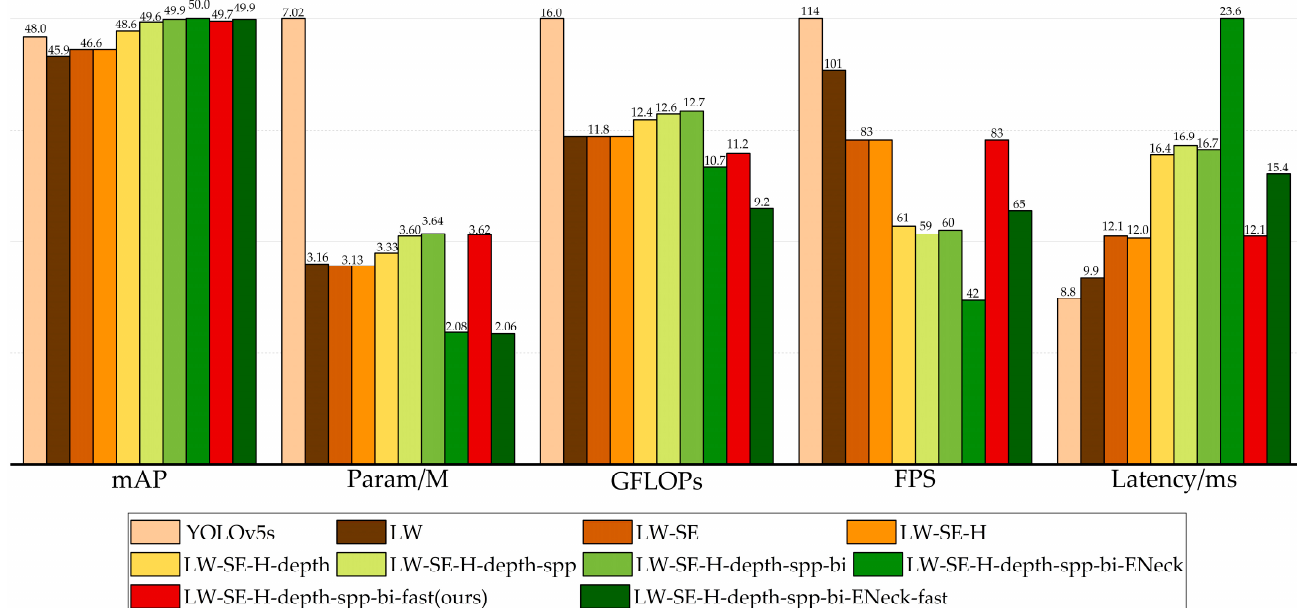
Figure 10. Ablation result of di ff erent methods on the test set.